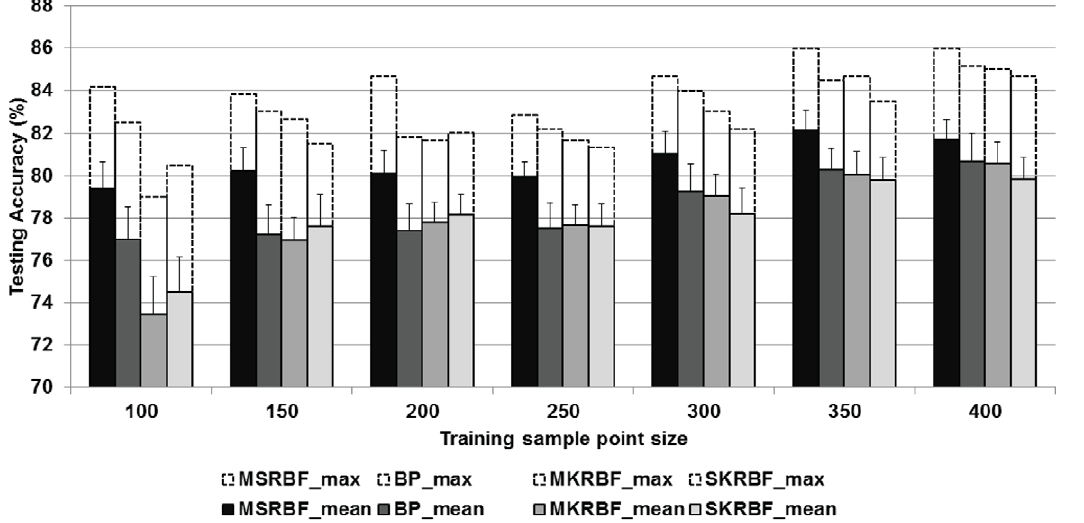
Figure 7. Accuracy comparison among four network types.